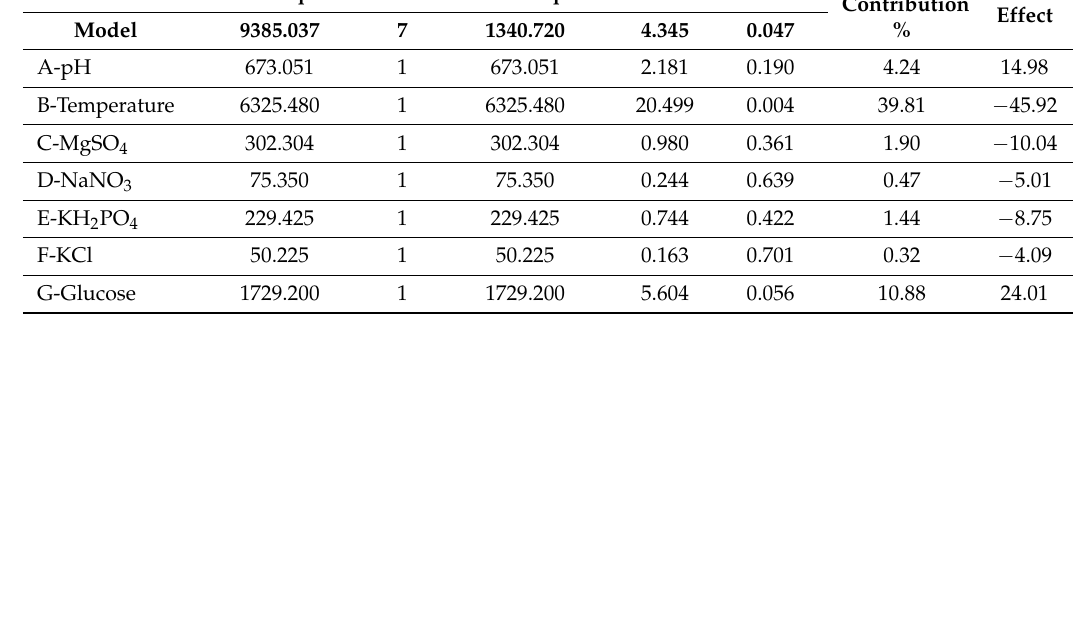
second-order polynomial equation: